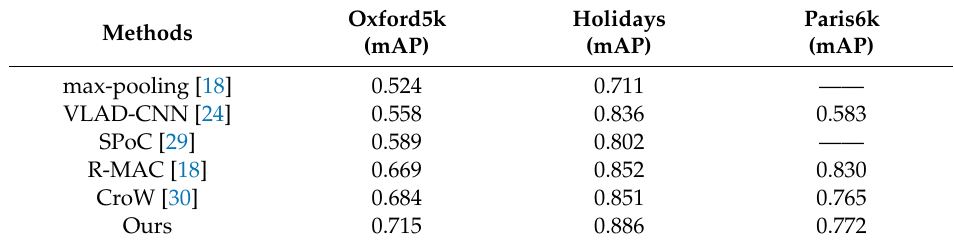
Table 3. Comparison of detection accuracy between our method and the state-of-the-art methods on three di ff erent